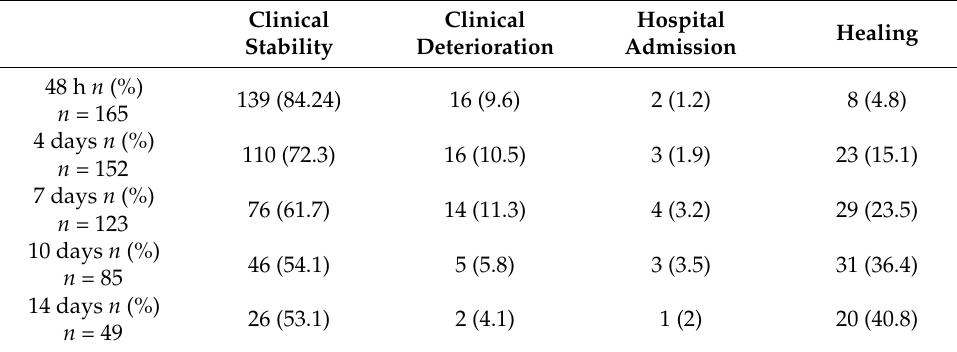
Table 2. Patients’ clinical evolution during the 14 days phone monitoring.